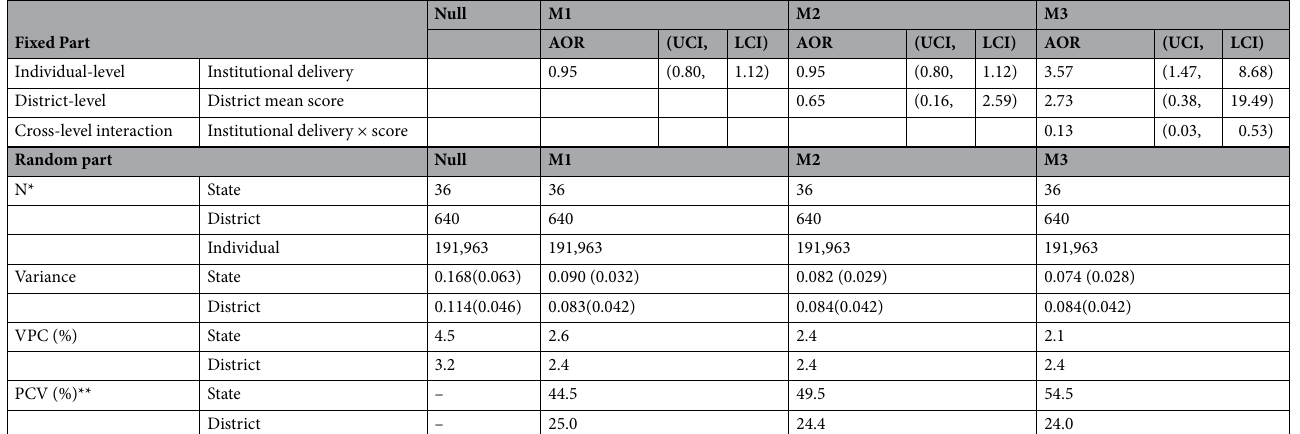
Table 3. Association of institutional delivery and district-level health system quality with neonatal mortality (N = 191,963). M1 –M3: Adjusted for newborn gender, birth order & birth interval, multiple